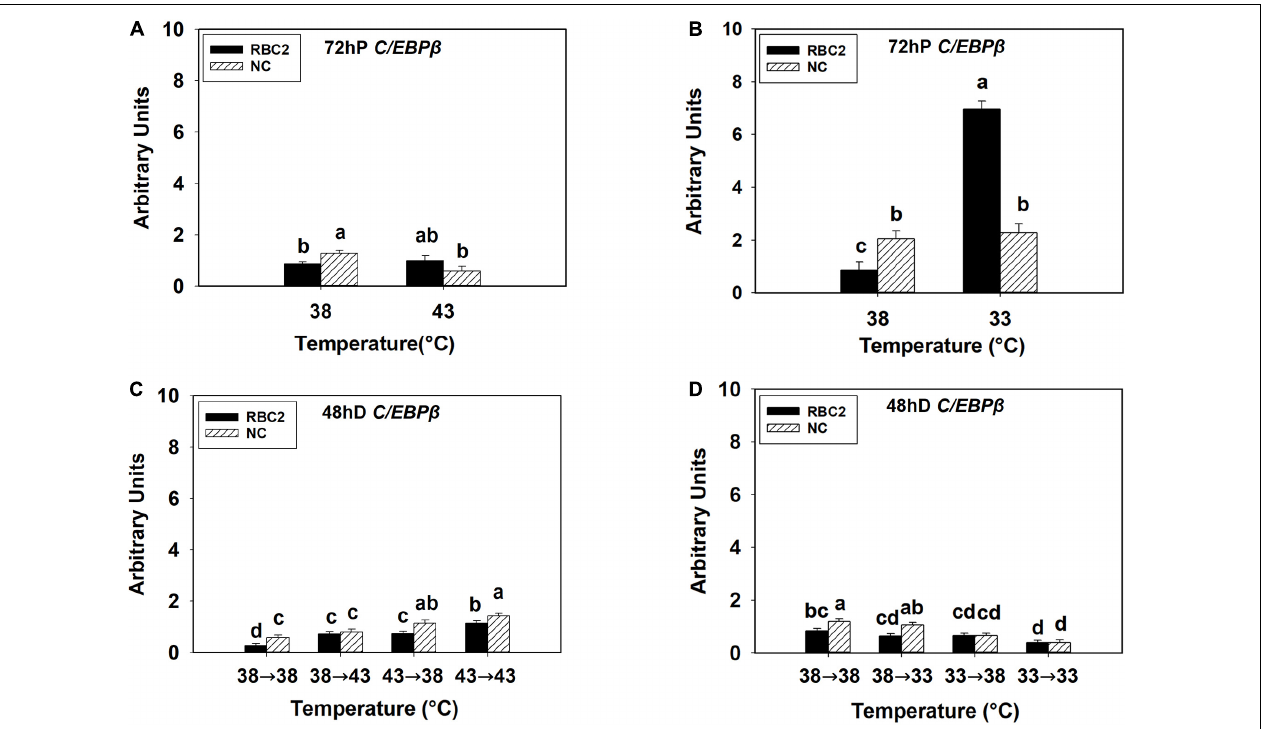
FIGURE 2 | Expression of CCAAT/enhancer-binding protein beta ( C/EBP β ) at 72 h of proliferation (72 hP) and 48 h of differentiation (48 hD) in satellite cells isolated from the pectoralis major (p. major) muscle of 7-day-old Randombred Control Line 2 (RBC2) and 7-day-old Nicholas Commercial (NC) turkeys. (A) Satellite cell proliferation at 38 ◦ or 43 ◦ C for 72 h. (B) Satellite cell proliferation at 38 ◦ or 33 ◦ C for 72 h. (C) Satellite cell proliferation for 72 h and differentiation for 48 h, both at 38 ◦ C (38 ◦ → 38 ◦ C); proliferation at 38 ◦ C for 72 h and differentiation at 43 ◦ C for 48 h (38 ◦ → 43 ◦ C); proliferation at 43 ◦ C for 72 h and differentiation at 38 ◦ C for 48 h (43 ◦ → 38 ◦ C); or proliferation for 72 h and differentiation for 48 h, both at 43 ◦ C (43 ◦ → 43 ◦ C). (D) Satellite cell proliferation for 72 h and differentiation for 48 h, both at 38 ◦ C (38 ◦ → 38 ◦ C); proliferation at 38 ◦ C for 72 h and differentiation at 33 ◦ C for 48 h (38 ◦ → 33 ◦ C); proliferation at 33 ◦ C for 72 h and differentiation at 38 ◦ C for 48